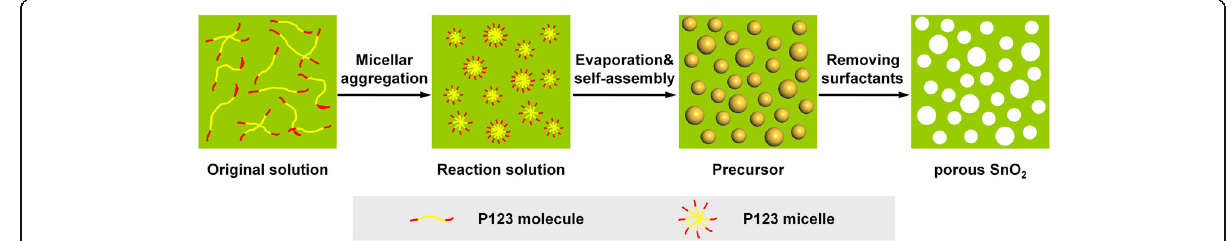
Fig. 1 Schematic illustration of the synthetic procedure of mesoporous SnO 2